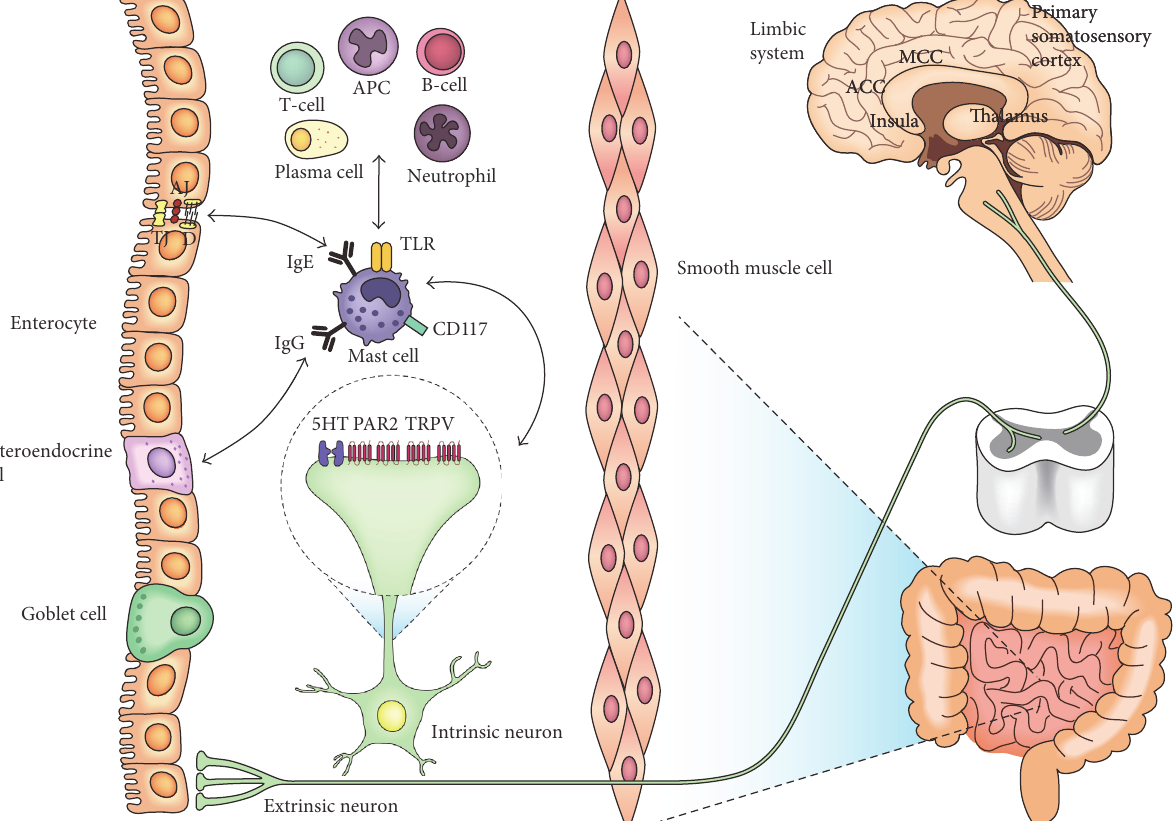
Figure 1:The putativeroleof mast cells in IBS. Both symptoms of IBS, abdominal pain and stool changes, could be mediated by intestinal mast cells. Located close to the intrinsic or extrinsic nerve fibers, mast cells can stimulate the adjacent nerve fibers conveying nociceptive signals to the CNS. These signals could be perceived as painful by interaction with other contributing factors including cognitive and affective function by cerebral cortical and subcortical regions. Mast cells activated by serotonin secreted from enteroendocrine cells release mediators and then the mediators evoke local physiologic reflex response by intrinsic and extrinsic nervous systems, altering peristalsis, perfusion, and secretion which impact intestinal transit and luminal fluid content, therefore developing diarrhea or constipation as well as abdominal pain. Also, mast cells activated by serotonin or by stress-induced efferent neuronal stimulation degranulate mediators, which in this time activate other immune cells. These immune cells may be involved in epithelial secretion or mucosal permeability changes. This intestinal barrier dysfunction may be led by mast cell-associated degradation of various epithelial gap junctional